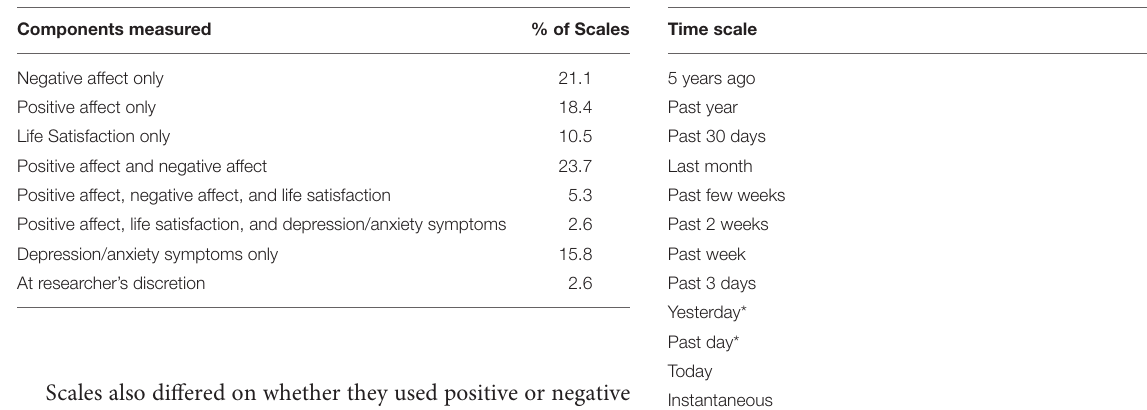
TABLE 4 | Components of subjective wellbeing measured, N = 38. TABLE 5 | Time periods covered by the scales, N = 28.